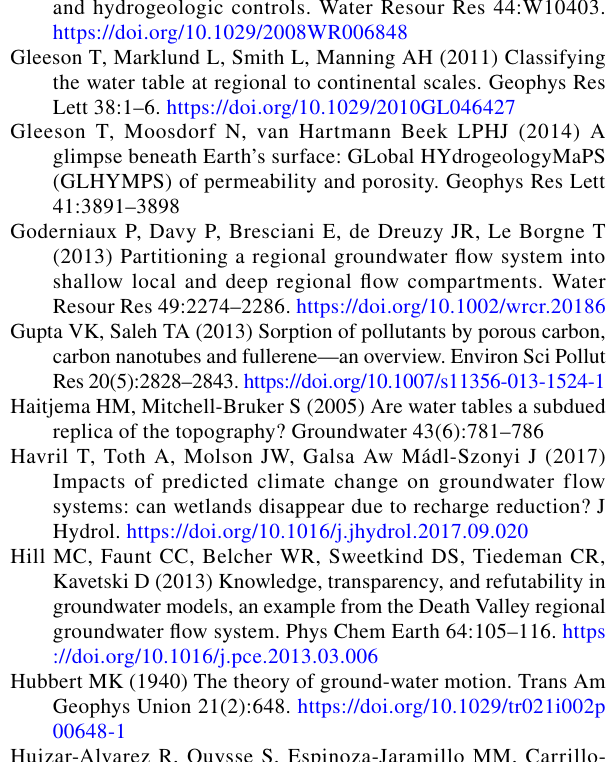
ing of water table elevations using collateral information from a digital elevation model. J Hydrol